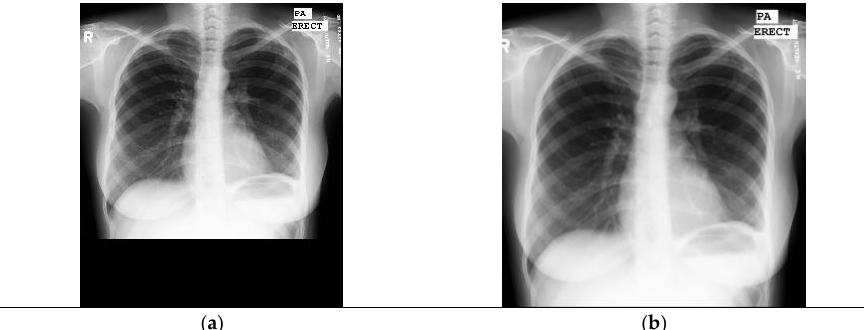
Figure 4. Center region cropping applied to the Montgomery County dataset. ( a ) Shows the original image with black bands; ( b ) shows the preprocessed image.